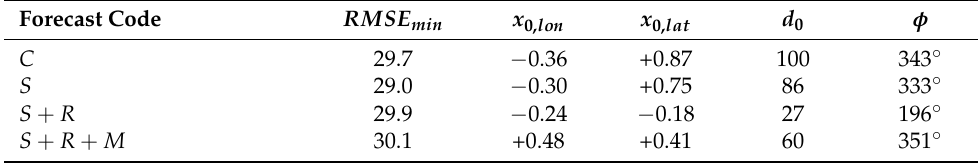
Table 5. Parameters of the roto-translation minimizing the RMSE between observed and predicted values extracted at the 91 rain gauge locations located within the gray and black circles, respectively, shown in Figure 8. RMSE min is the error after the minimizing roto-translation; x 0, lon and x 0, lat are the coordinates of the translation vector x 0 defined in Equation (5); d 0 indicates the distance, in km, between the centers of the black and gray circles (i.e, the dashed segment of Figure 8) and is given in Equation (7). The angle φ indicates the rotation amplitude with respect to north, counterclockwise. Forecast Code RMSE